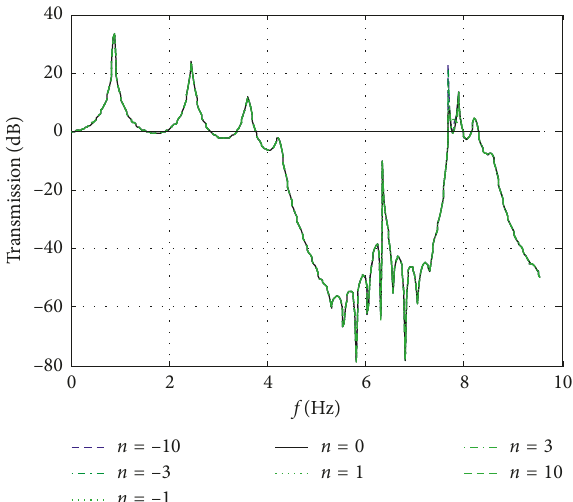
Figure 7: Transmission characteristics with different n ( K